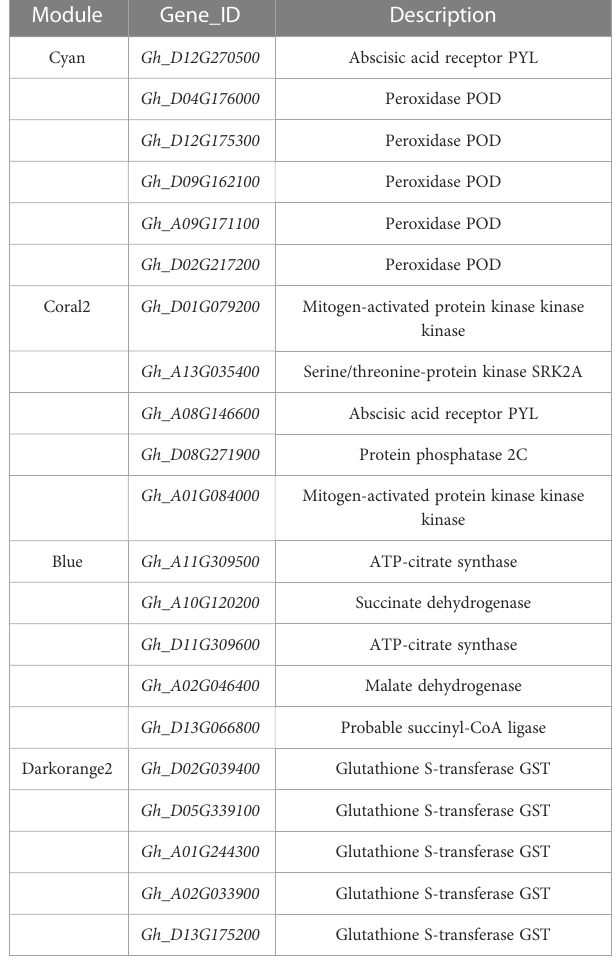
TABLE 1 Details of hub genes in key co-expression